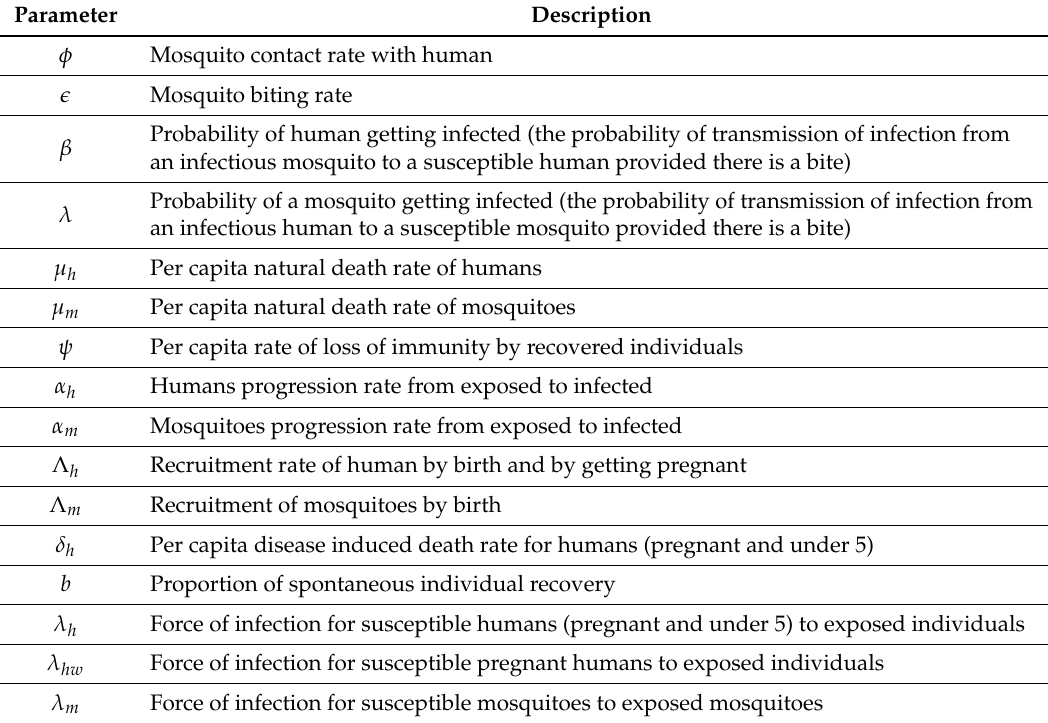
Table 2. Description of parameter variables of the malaria